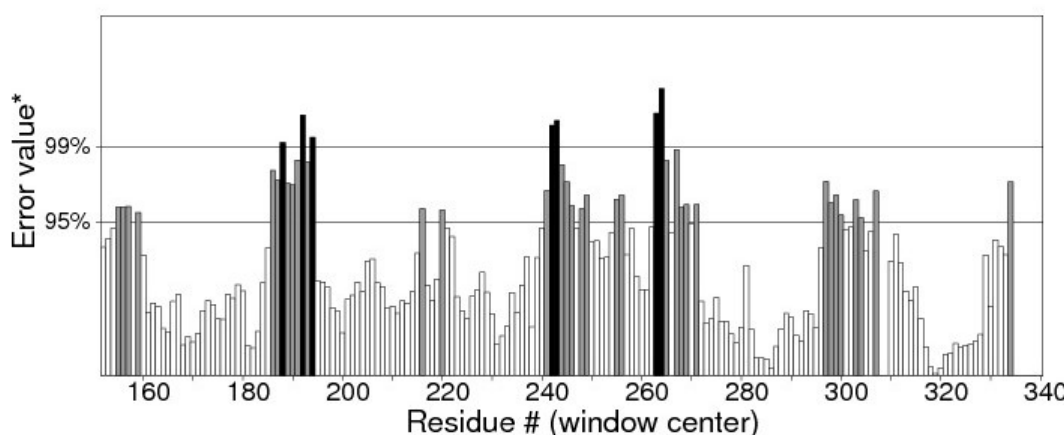
Figure 4. Quality estimation of model 2 protein structure. * On the error axis, two lines are drawn to indicate the confidence with which it is possible to reject regions that exceed that error value.